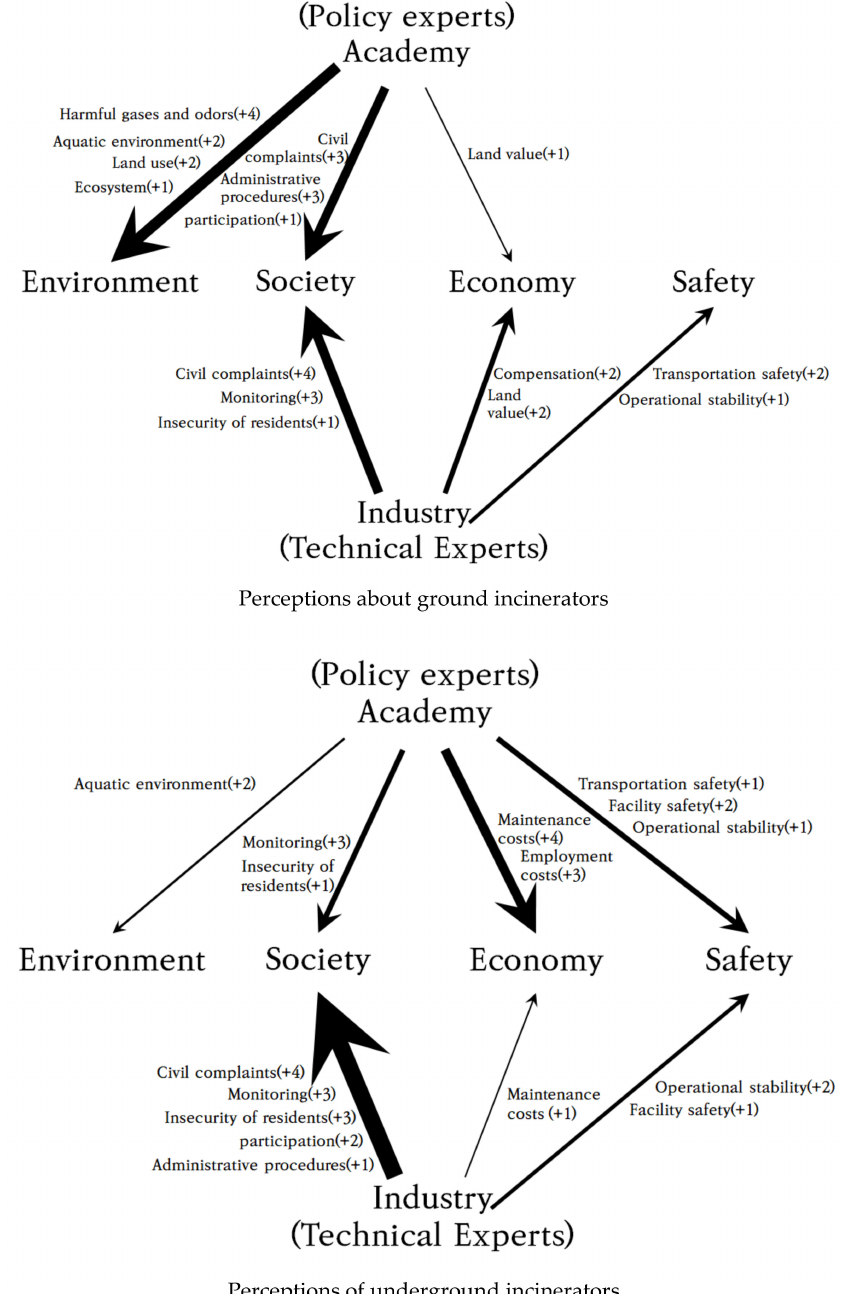
Figure 3. Perceptions of ground and underground incinerators. (Line thickness is expressed as the sum of positive